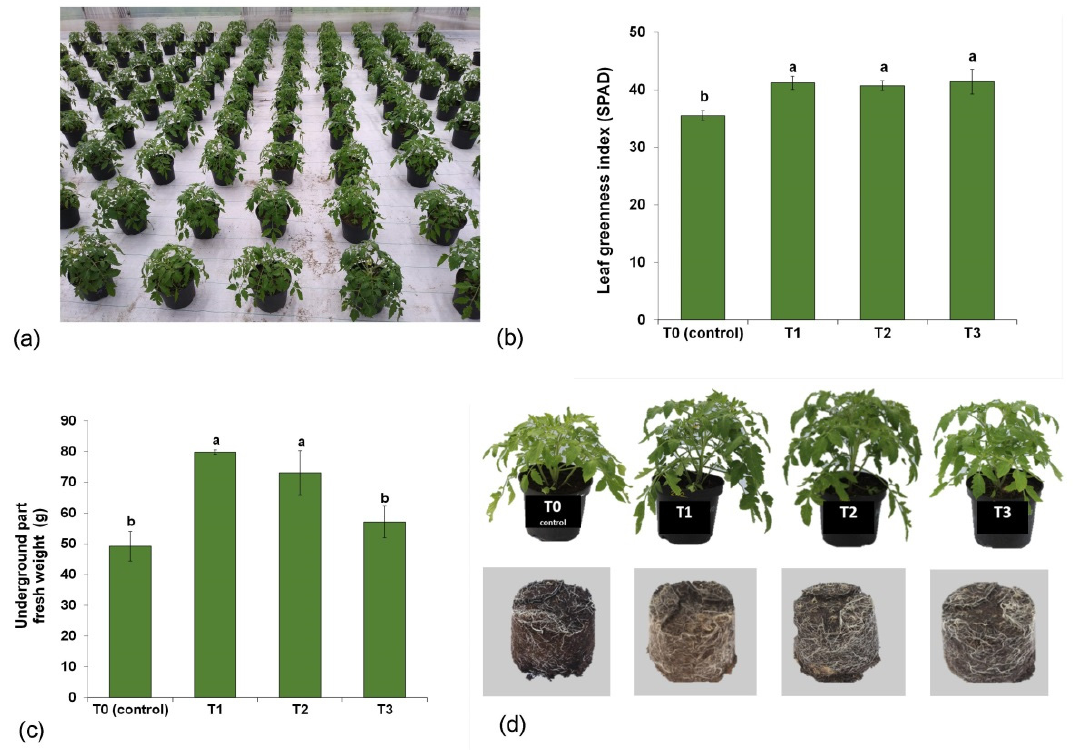
Figure 3. Effect of compost-enriched media: T0 (control—100% peat substrate); T1 (25% compost, 30% sphagnum peat, 15% fen peat, 20% pine bark, 10% wood fiber); T2 (30% compost, 20% sphagnum peat, 30% fen peat, 10% pine bark, 10% wood fiber); and T3 (30% compost, 0% sphagnum peat, 30% fen peat, 30% pine bark, 10% woody fiber) on the growth of plants in a plastic tunnel: ( a ) plants after 3 weeks of growing in the substrates; ( b ) leaf greening index SPAD; ( c ) biomass of the aboveground part; ( d ) visual comparison of the aboveground part and the root system. Vertical errors bars indicate the standard error of the mean. Different letters indicate a significant difference at p ≤ 0.05.